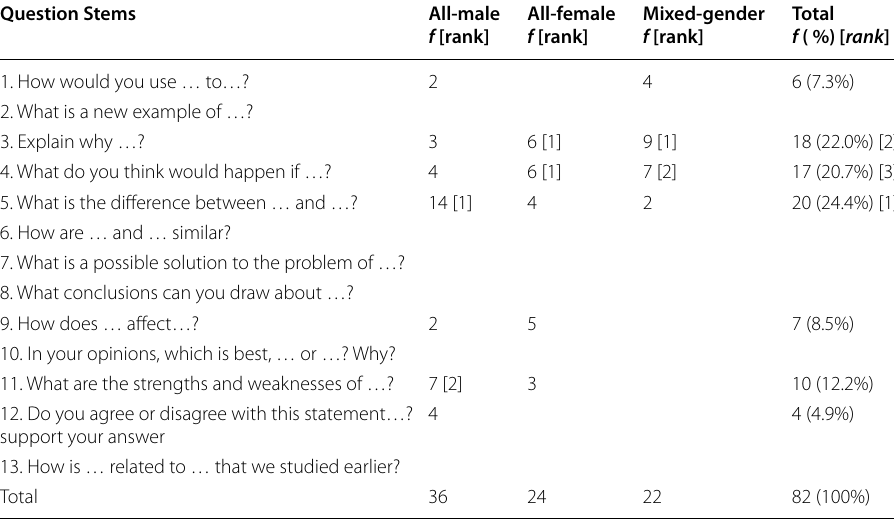
Table 5 Use of ‘Generic Question Stems’ by different group compositions Question